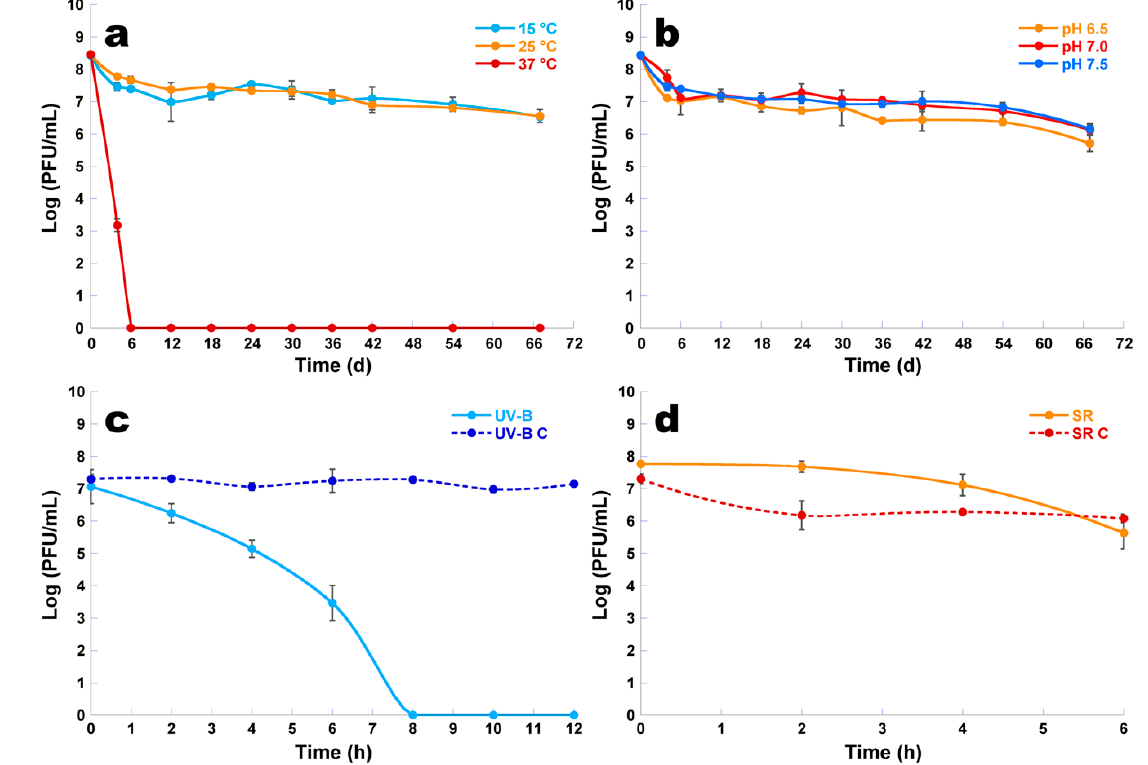
Figure 8. Survival of phage φ 6 following exposure to different temperature values ( a ), different pH values ( b ), UV-B irradiation ( c ), and solar radiation ( d ). Values represent the mean of three independent experiments; error bars represent the standard deviation. UV-B: phage exposed to UV-B irradiation; UV-B C: phage control—phage not exposed to UV-B irradiation; SR: phage exposed to solar radiation; SR C: phage control—phage not exposed to solar radiation.